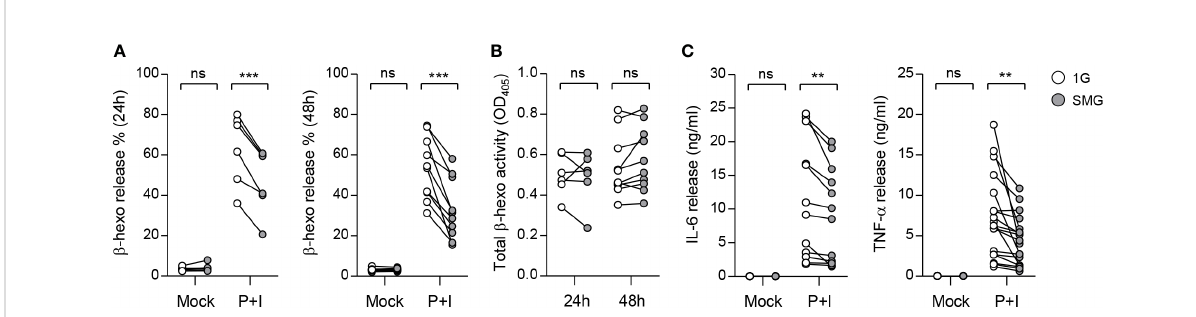
FIGURE 4 Effects of SMG on mast cell functions. BMMCs were exposed to SMG for 24 to 48 h, and then incubated in Tyrode ’ s solution with either 50 ng/ml phorbol 12-myristate-13-acetate (PMA) plus 250 ng/ml ionomycin (P+I) or DMSO (Mock). (A) Degranulation was accessed by measuring b -hexosaminidase release at 15 min after stimulation. Pairwise scatter plots represented the percentages of released b -hexosaminidase (n = 6 at 24 h; n = 10 at 48 h). (B) Total b -hexosaminidase activity in (A) was measured using a cell supernatant dissolved in Triton X-100 and represented by a scatter graph. (C) Cells were exposed to SMG for 48 h and the amounts of IL-6 and TNF- a cytokines in the culture media were determined using ELISA at 6 h after stimulation (n = 12 in IL-6; n = 18 in TNF- a ). **p < 0.01 and ***p < 0.001, Student ’ s t-test. ns, not signi fi